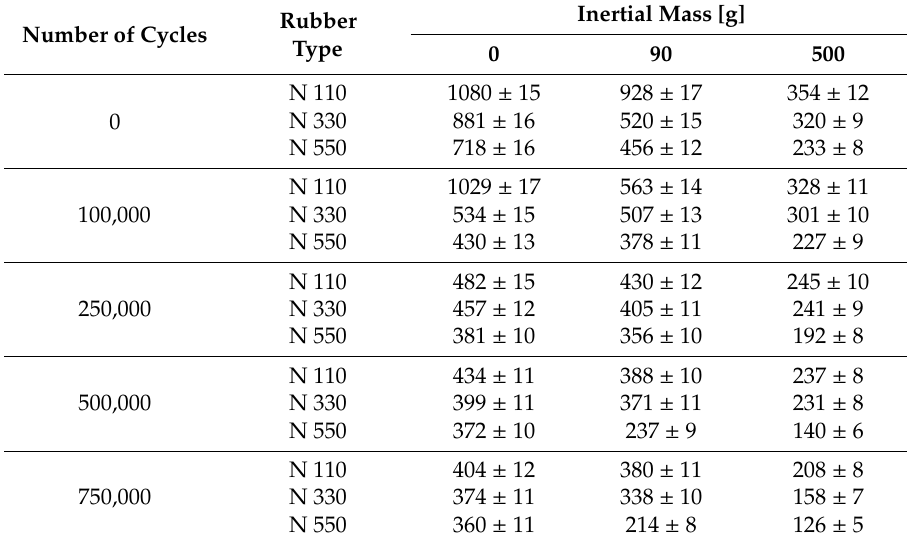
Table 5. The first resonance frequency (f R1 ) in Hz of the studied rubber composite materials measuring t = 20 mm in thickness, as induced by harmonic force vibration for di ff erent inertial masses and numbers of loading cycles.